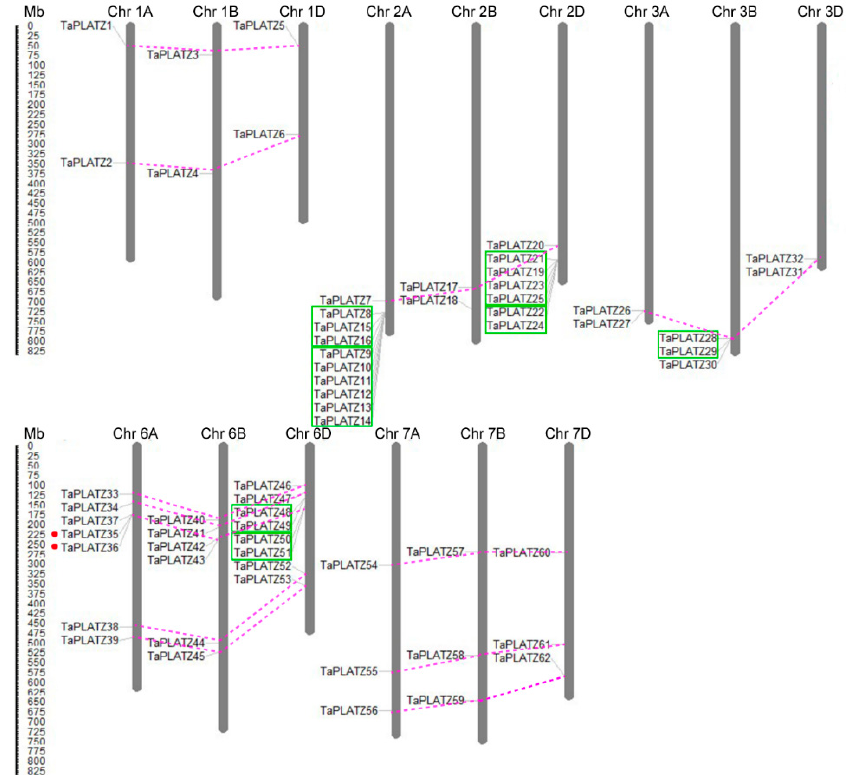
Distribution and duplication of TaPLATZ genes in Triticum aestivum chromosomes. The chromosome numbers are shown at the top of each bar. The length of chromosomes was their relative extent. The scale on the left is in megabases (Mb). Putative TaPLATZ homologous gene pairs were ligated with violet dotted lines. The tandem duplicated genes were marked with green boxes. Segmental duplicated genes were marked by red dots.